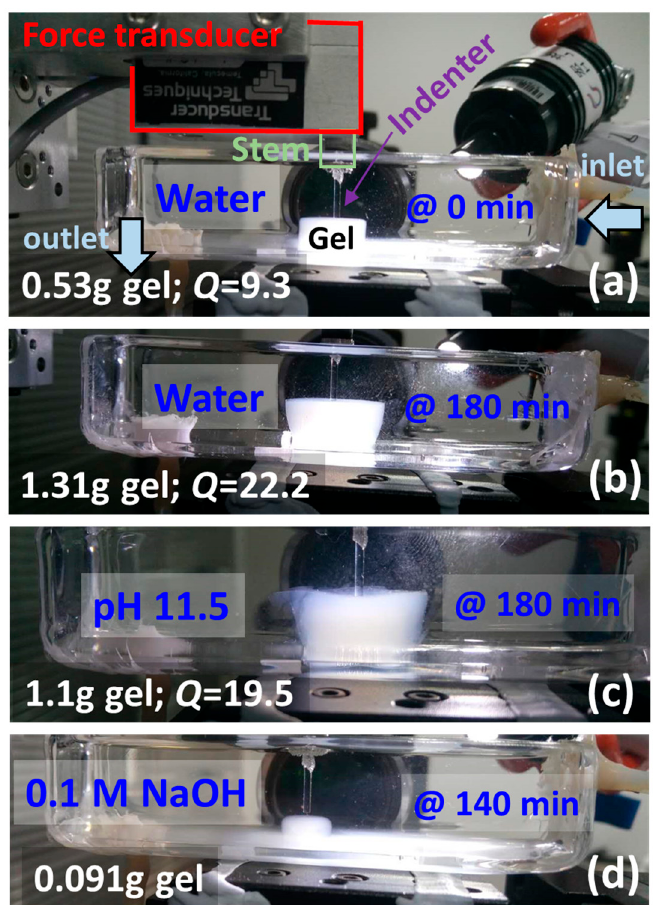
Figure 1. Experimental setup for the dynamic mechanical characterization of hydrogels by indentation. ( a ) Right after the gel is immersed in water, and ( b ) after 180 min; ( c ) in pH 11.5 after 180 min and ( d ) in 0.1 M NaOH after 140 min. The weight of the gels, as well as the calculated overall volumetric swelling degree Q , is also shown. Note that there is extensive dissolution in ( d ).